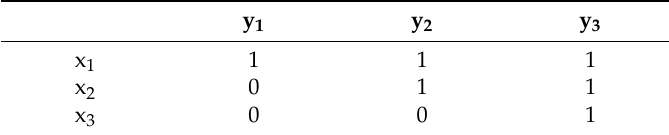
Table 1. All potential individual matches involving x and y